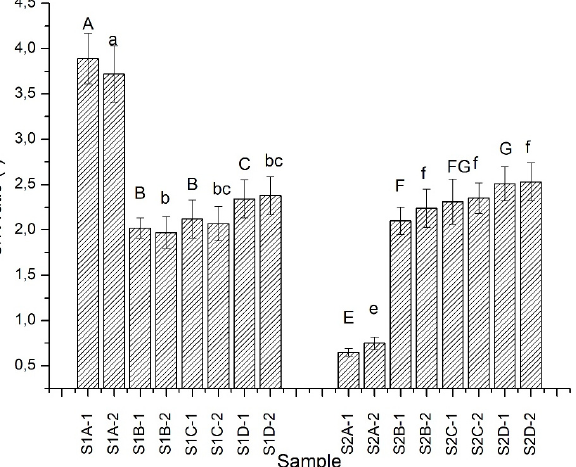
Figure 6. C/N ratio in the studied soils. S1: soil from the limestone open-cast mining remediated with embankment; S2: soil from the lignite open-cast mining remediated with sewage sludge; subsequent letters A–D mean different remediated areas located at the same mine; subsequent numbers mean different sampling periods; 1: spring 2021, 2: spring 2022. Mean values ± SD, n = 3. Different letters with bars indicate significant differences between tested treatments ( p < 0.05) according to Tukey’s test. Small and large letters indicate separate analyses for both sampling